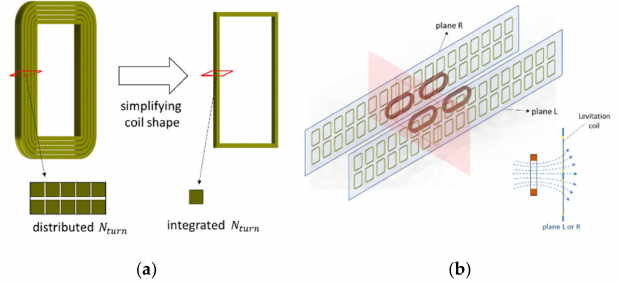
Figure 4. Developing an e ffi cient model for analyzing a null-flux EDS device: ( a ) simplifying a levitation coil to the integrated N turns of the rectangle, ( b ) the design in planes L and R where the coils are